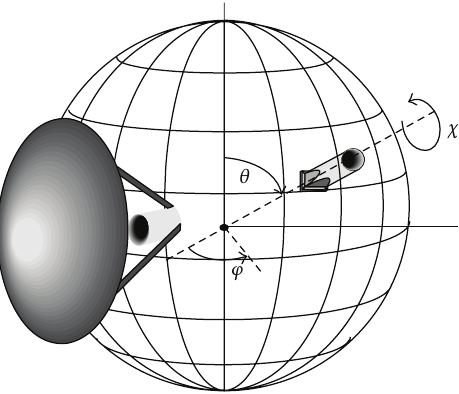
Figure 2: Internal spherical